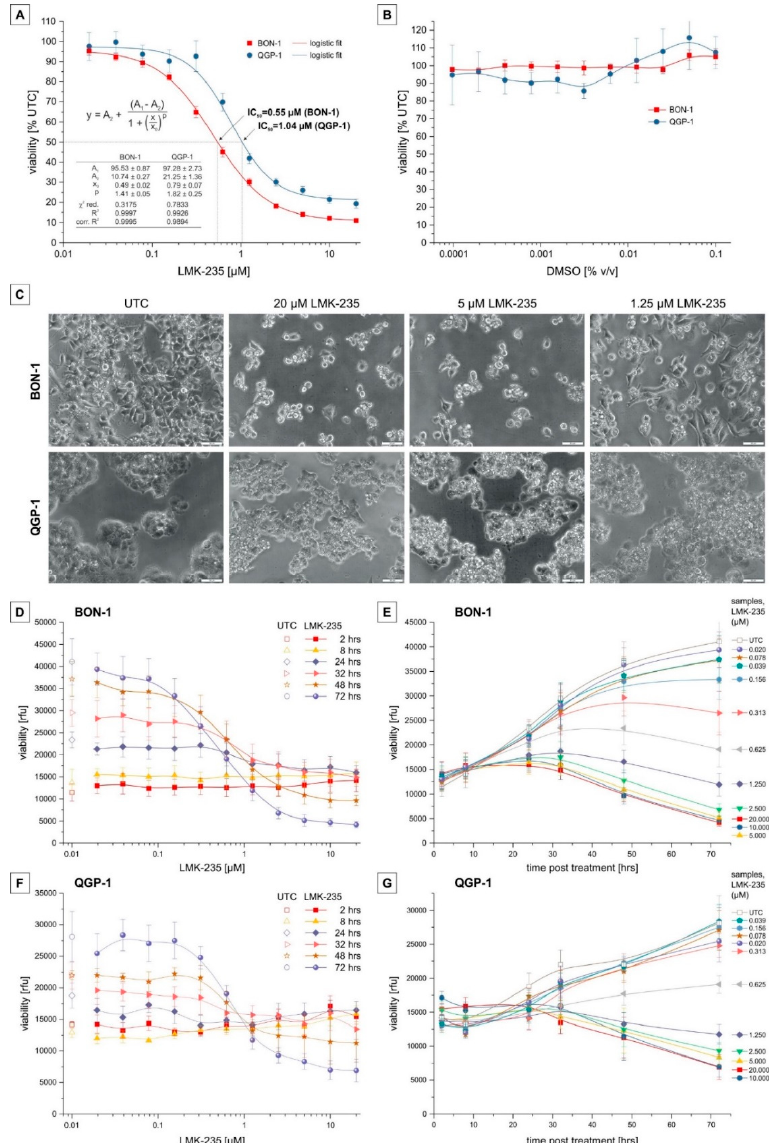
Figure 1. Cytotoxicity of LMK-235 on BON-1 and QGP-1. BON-1 and QGP-1 were incubated with different LMK-235 concentrations for up to 72 h. Viability was measured by the resazurin assay and displayed either as the percentage of untreated control (UTC) or relative fluorescence units (rfu). ( A , B ) 72 h treatment with a serial dilution of LMK-235 between 0.02–20 µM ( A ) for BON-1 (red; n = 9) and QGP-1 (blue; n = 8) cells and corresponding DMSO concentrations ( B ; n = 3). Data points represent mean ± SEM, fitted based on a logistic fit function ( A ). ( C ) Phase contrast images (200 × magnification) of BON-1 and QGP-1 treated for 72 h with 20, 5, and 1.25 µM LMK-235. Scale bar indicates 50 µm. ( D , F ) Cell viability displayed as absolute fluorescence units for BON-1 ( D ) and QGP-1 ( F ) incubated for different periods (2, 8, 24, 32, 48, 72 h) with LMK-235 concentrations ranging from 0.02 to 20 µM. ( E , G ) Cell viability displayed as absolute fluorescence units for BON-1 ( E ) and QGP-1 ( G ) treated with different LMK-235 concentrations (0.02–20 µM) for 2, 8, 24, 32, 48, or 72 h. ( D – G ) Data points represent means ± SEM of three experiments, interpolated with a B-spline function. Abbreviations: UTC = untreated control, rfu = relative fluorescence units.